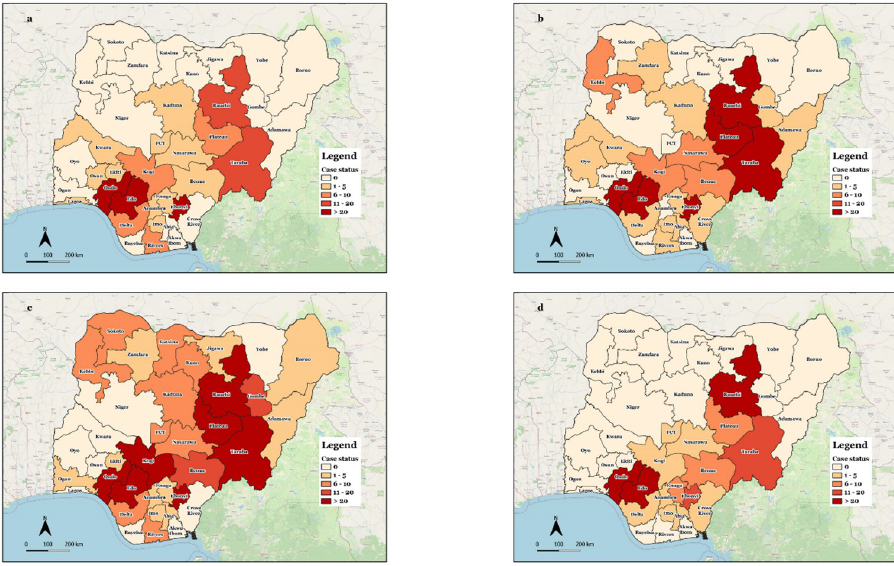
Fig 4. Distribution of Lassa fever cases by state, 2018–2021 (2018 {4a}; 2019 {4b}; 2020 {4c}; 2021